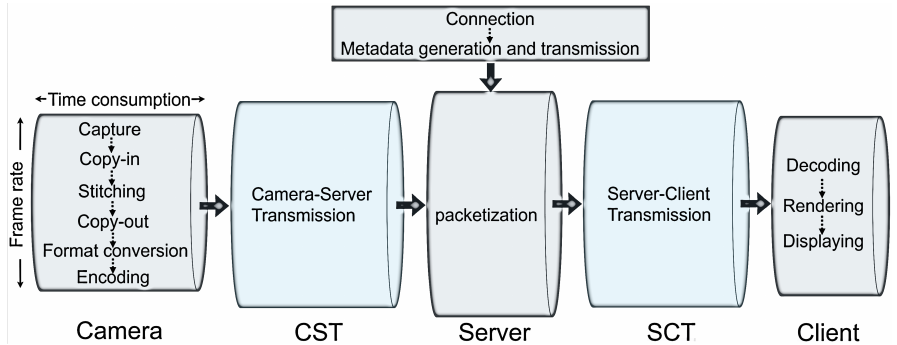
Figure 1. The architecture of 360° video camera sensing and the tasks of the 5 system components. The top rectangle represents one-time tasks whereas the 5 bottom pipes are the pipeline tasks that must be passed through for every